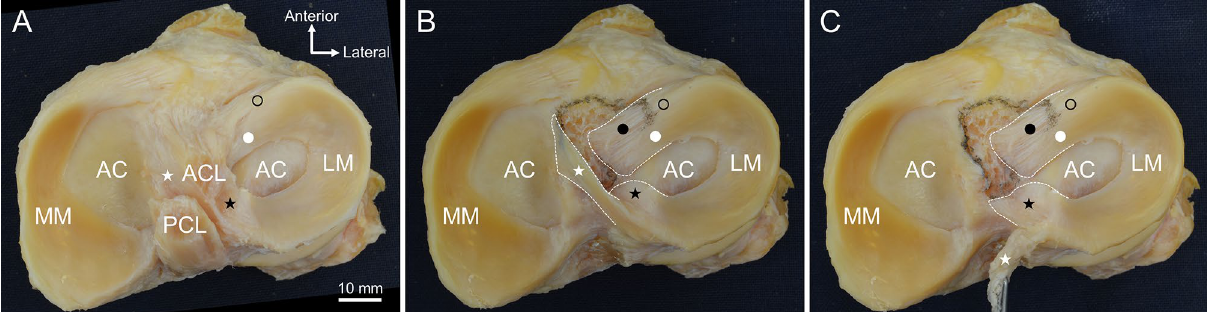
Figure 2. The relationship between the ACL attachment and the anterior and posterior horns of LM. ( A ) The superior aspect of the tibial side of ACL and LM. The superficial layer of the outer fibers of the anterior horn of LM (black circle) is connected to the ACL fibers. ( B ) After removing the ACL, while marking the margin of its attachment with a black pen. The deep layer of the outer (black dot) and inner fibers (white dot) of the anterior horn of LM extend into the intercondylar area and fit into the concave lateral border of the ACL attachment. The posteromedial crus (white star) is wrapped around the posteromedial side of ACL, and its attachment edge coincides with the medial border of the ACL attachment. ( C ) After removing the attachment of the posteromedial crus of the posterior horn of LM and flipping it posteriorly. The attachment edge of the anterolateral crus (black star) of the posterior horn of LM coincides with the posterior border of the ACL attachment. AC, articular cartilage; ACL, anterior cruciate ligament; LM, lateral meniscus; MM, medial meniscus; PCL, posterior cruciate